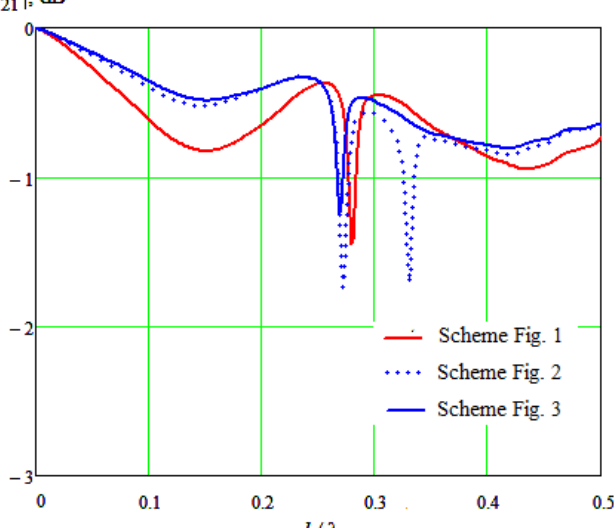
Fig. 10. The experimental dependence of insertion loss of a segment of a split strip line (diagram Fig. 1, 2 and 3) at the ratio of the length to the wavelength of the affecting signal in free space.